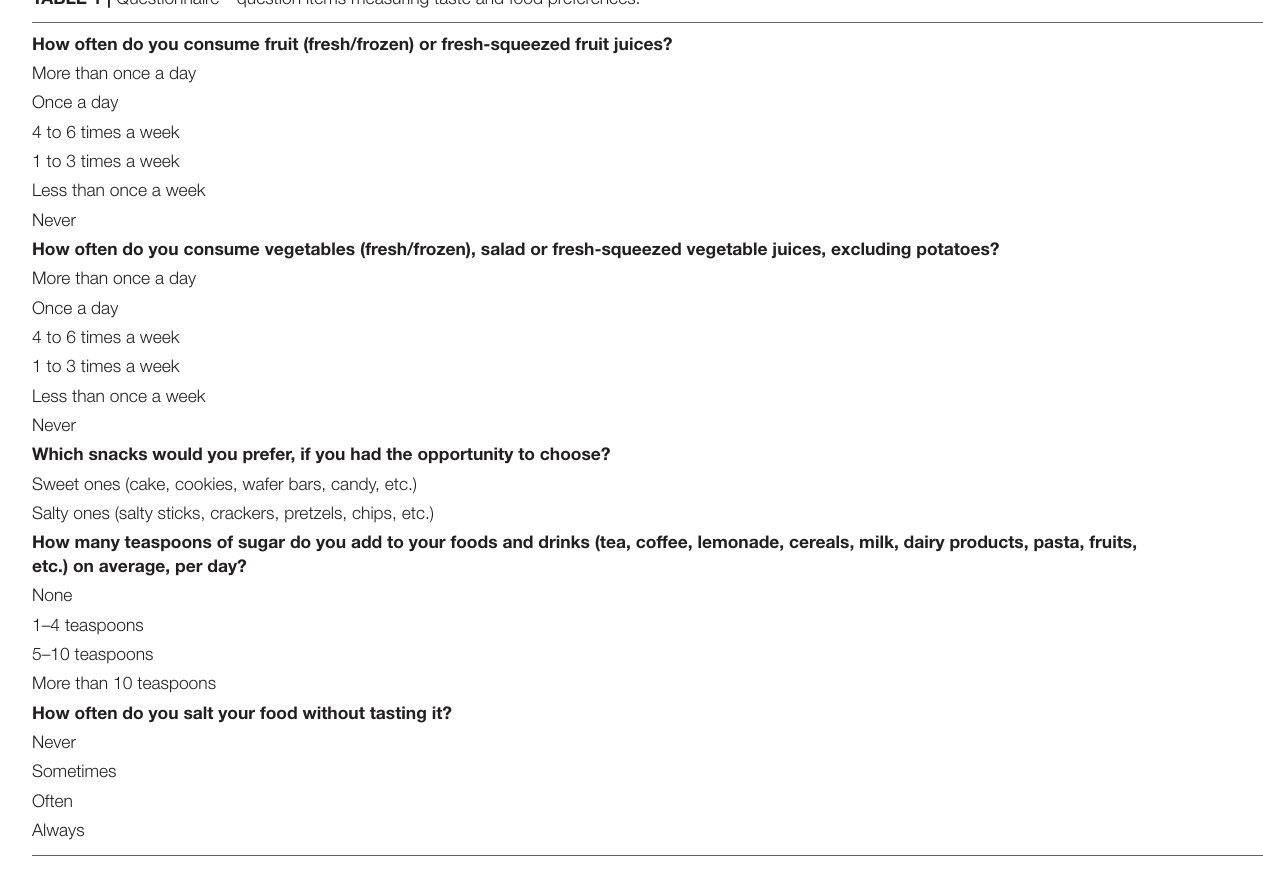
TABLE 1 | Questionnaire—question items measuring taste and food